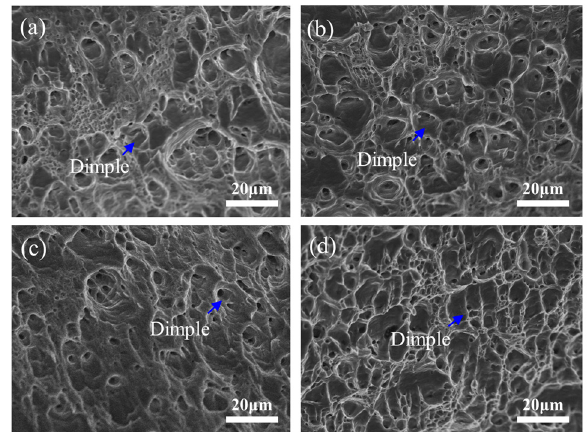
Figure 10. SEM images of tensile fracture of extruded alloys: ( a ) λ = 7, ( b ) λ = 13, ( c ) λ = 21, ( d ) λ =